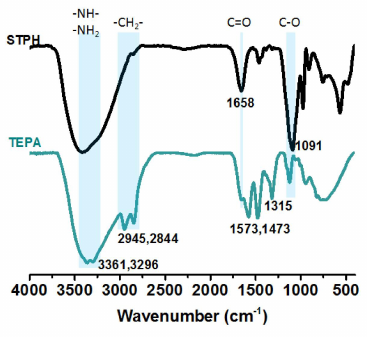
Figure 2. Fourier transform infrared (FTIR) spectroscopy characterization of the compound